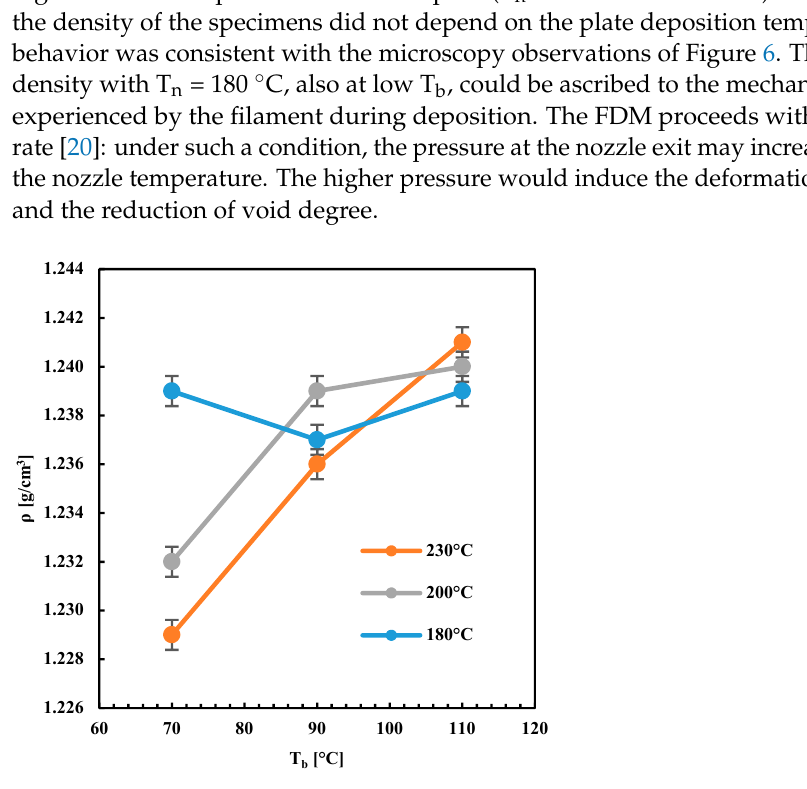
Figure 7. Bulk density of the specimens obtained with different T n and T b .